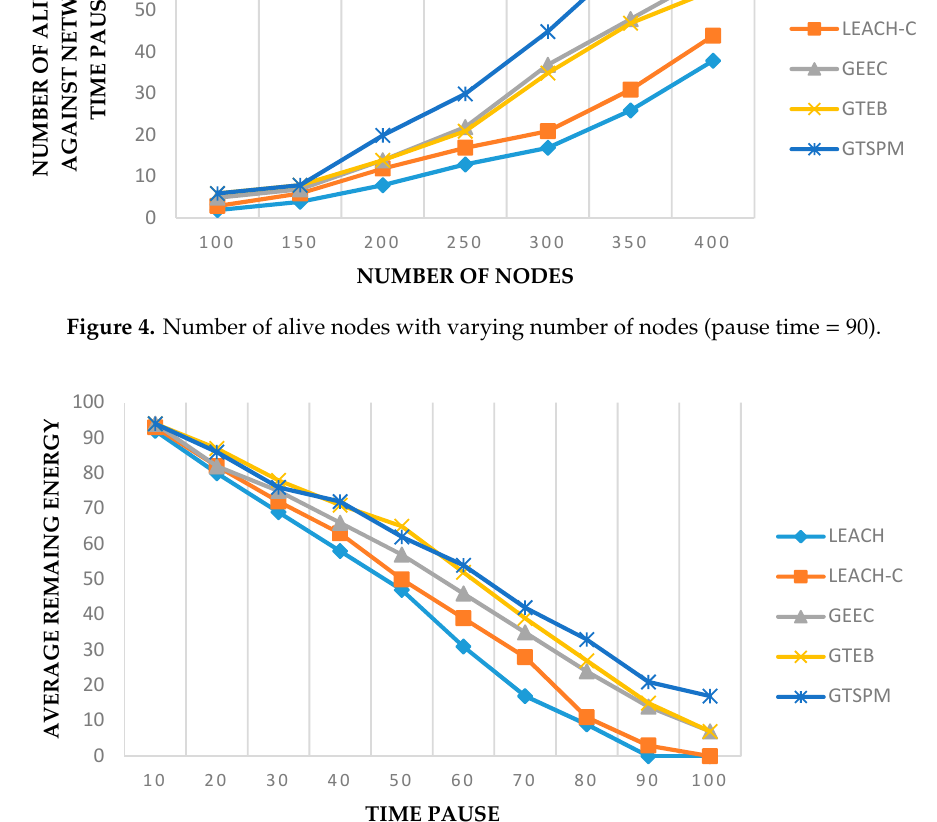
Figure 5. Average energy consumed over time (total nodes = 300).